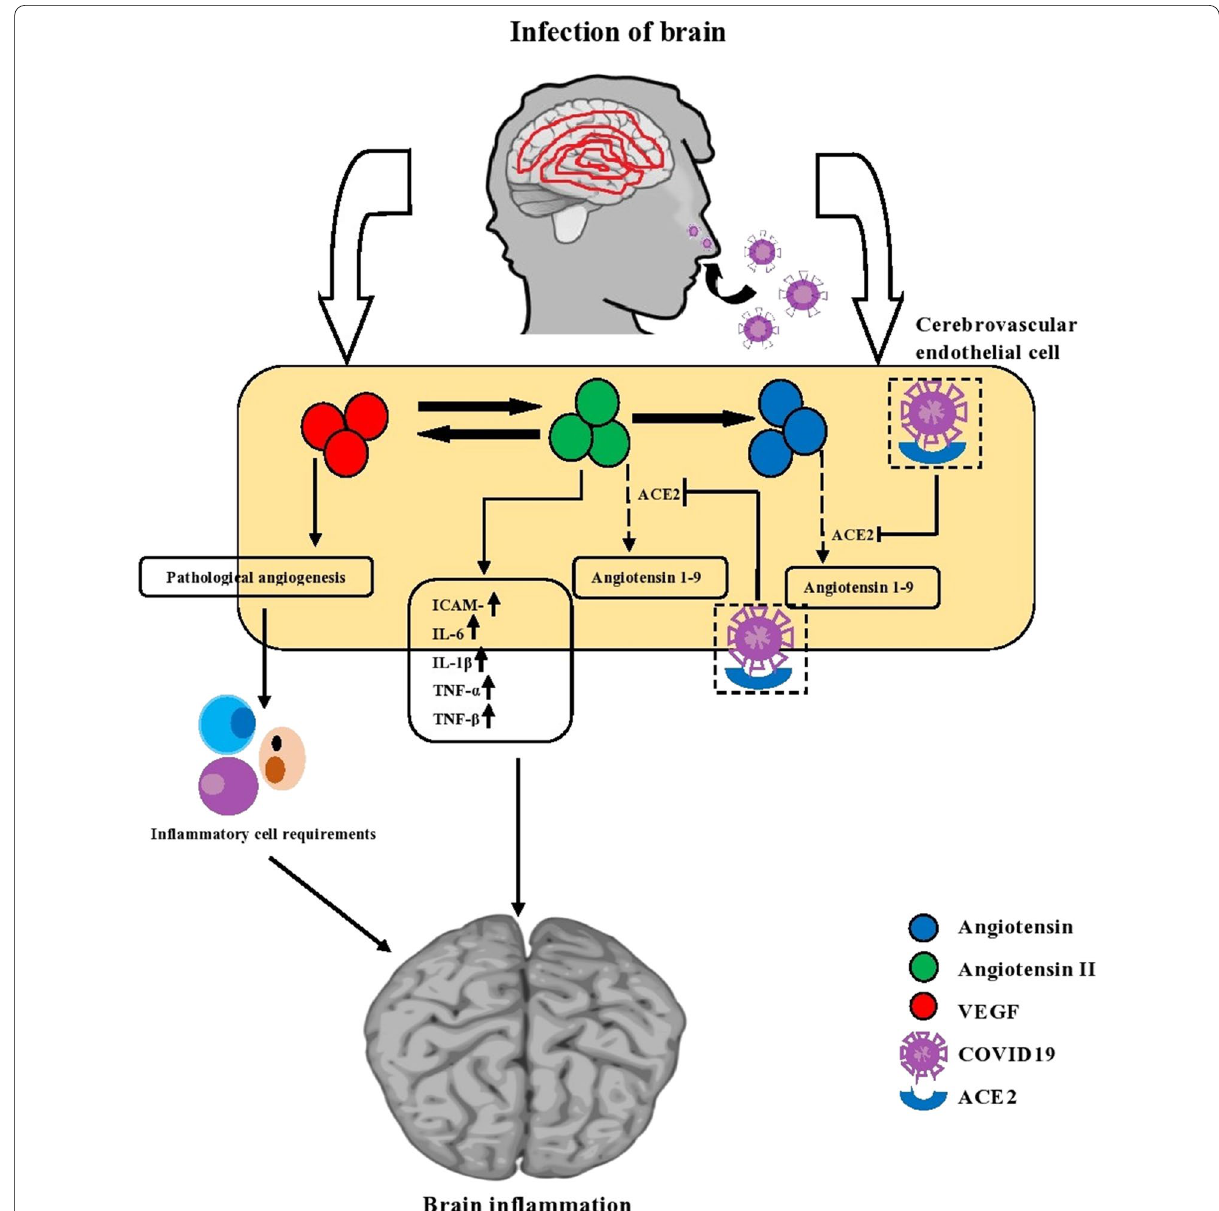
Fig. 10 Mechanism of VEGF, ACE2 gene function in brain inflammation due to